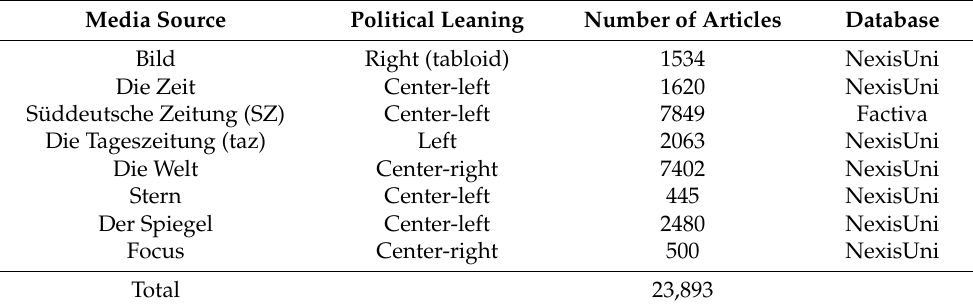
Table 1. German media sources for data collection (1 January 2010–31 December 2019). Media